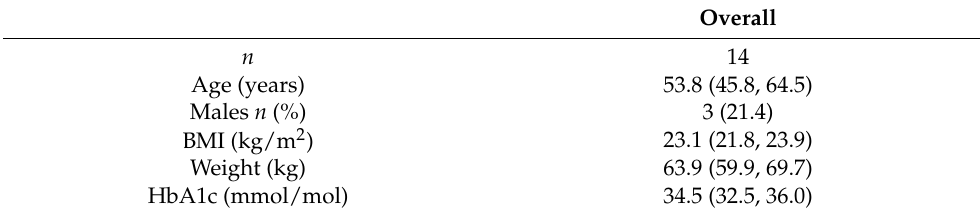
Table 1. Characteristics of the study population.